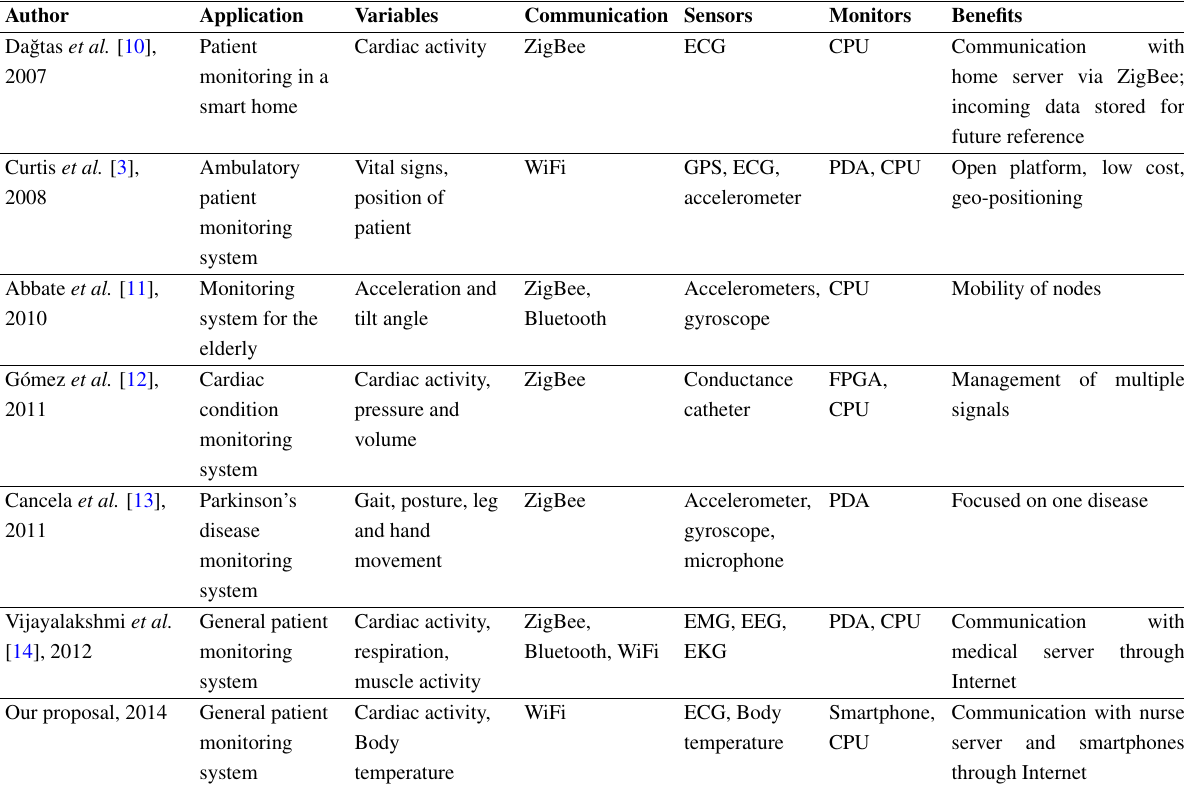
Table 1. Research on biomedical wireless monitoring